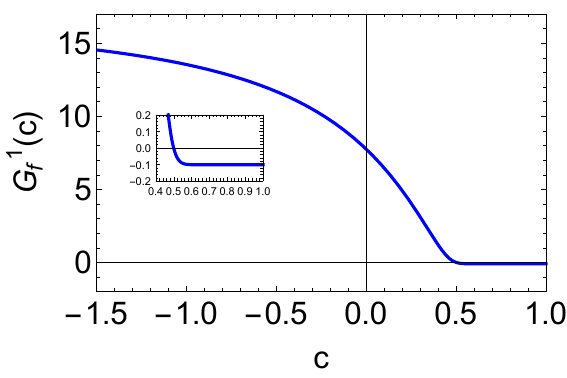
Figure 4 . Coupling (normalized with respect to the 4D coupling) of a fermion zero-mode with the n = 1 KK gauge (cid:12)eld, W ( n ) (cid:22) , as a function of the fermion localization parameter c [cf. eq.